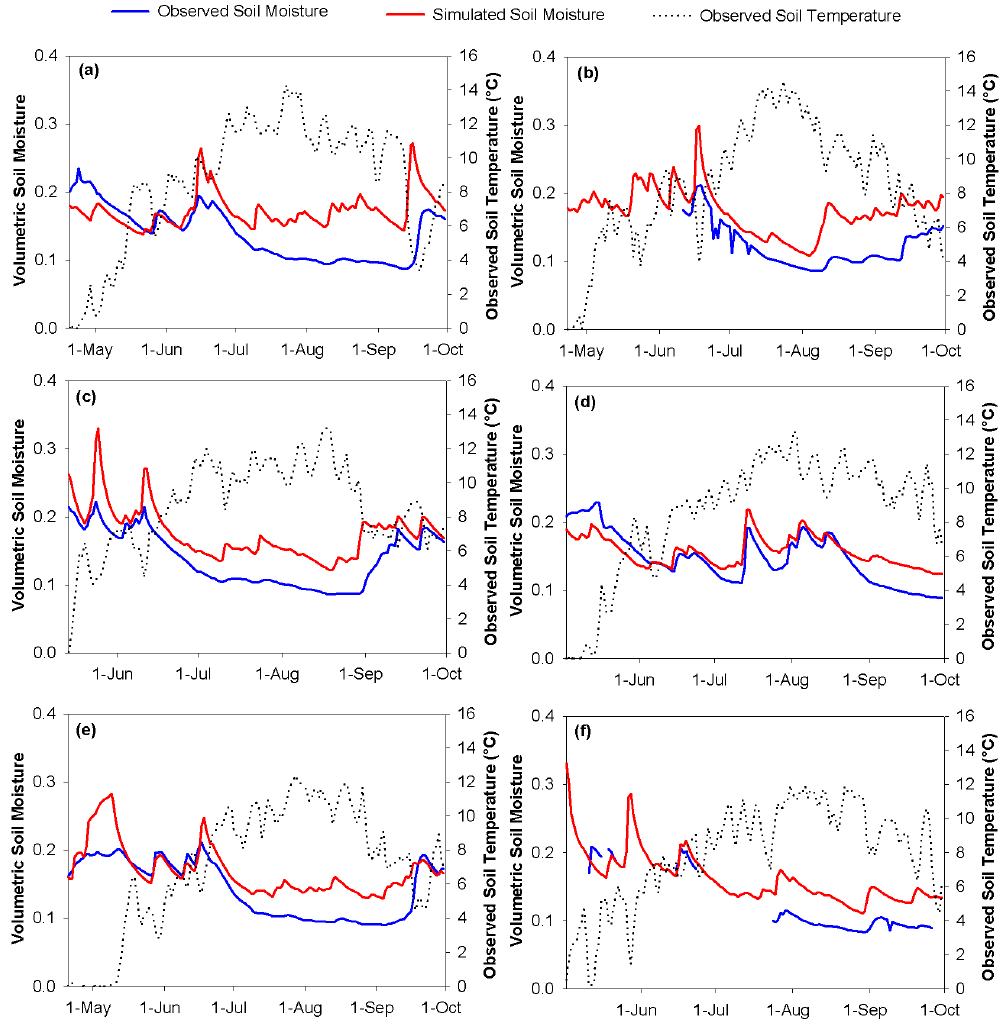
Fig. 8. Comparisons of the observed and simulated seasonal daily volumetric soil moisture at Level Forest in the MCRB. (a) 2006, (b) 2007, (c) 2008, (d) 2009, (e) 2010, and (f) 2011. Note that comparisons are valid only when the observed soil temperature is above 0 ◦